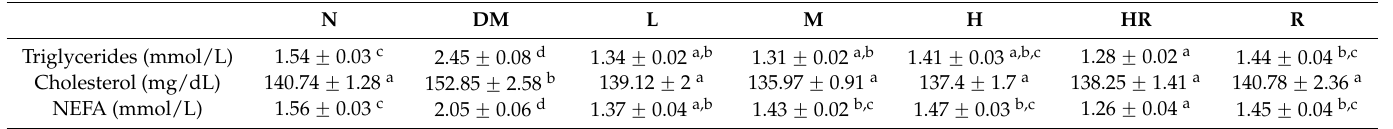
Table 3. Influence of red guava on triglycerides, cholesterol, and non-esterified free fatty acids.